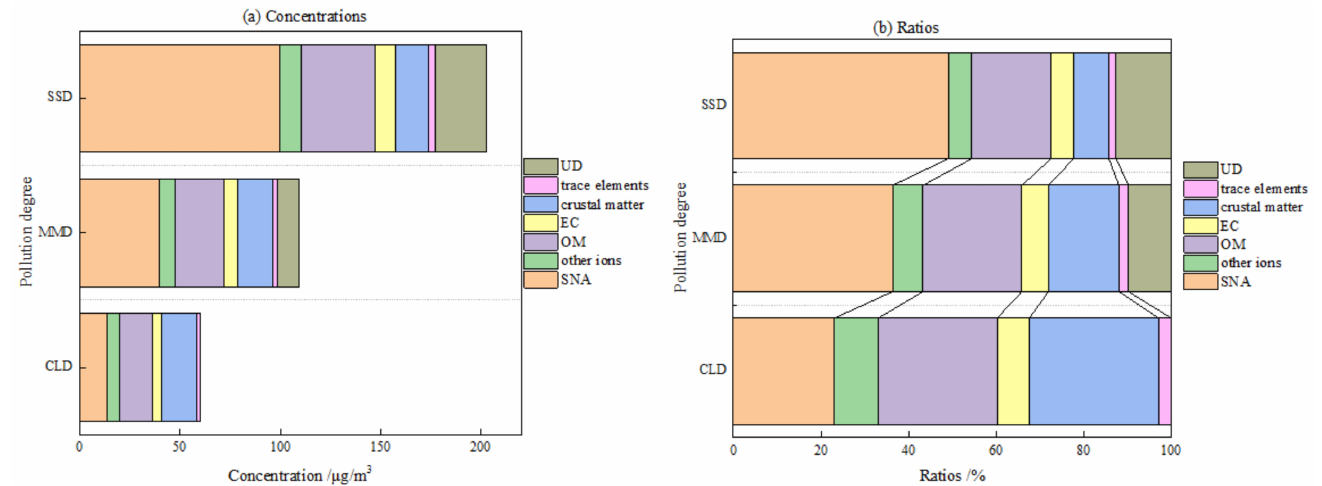
Figure 7. Reconstruction results of PM 2.5 with different pollution levels during the sampling